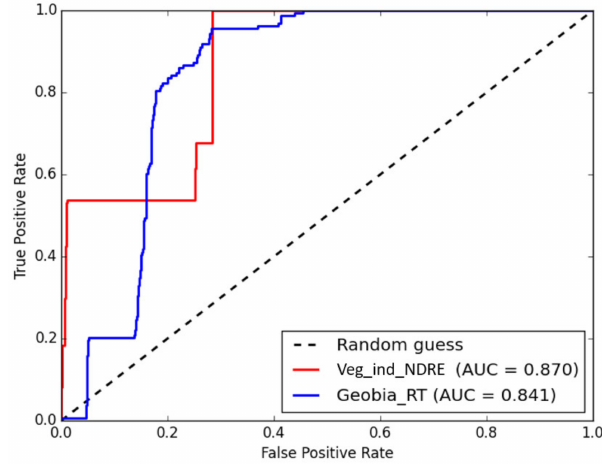
Figure 16. ROC curves and AUC values for 1000 points